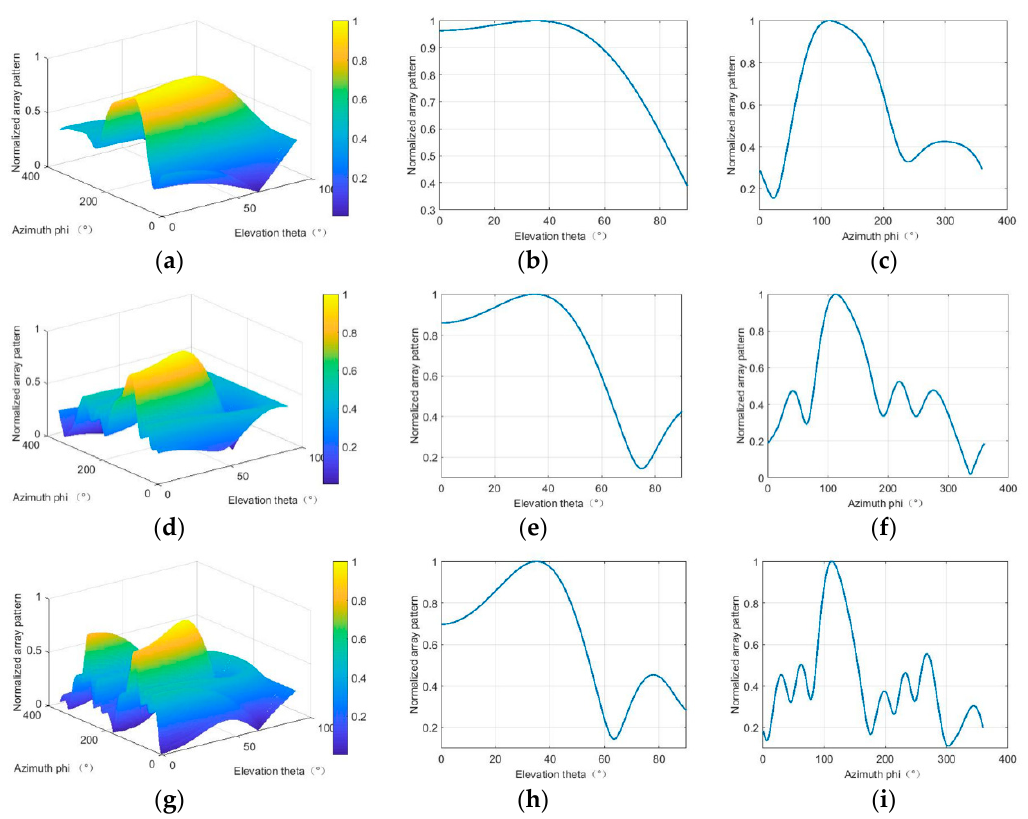
Figure 5. ( a ) is the normalized array pattern at the frequency point of 5 MHz. ( b , c ) are the sections of =113 =35 ϕ θ   ， , respectively. ( d – i ) are the corresponding simulation results of 10MHz and 15